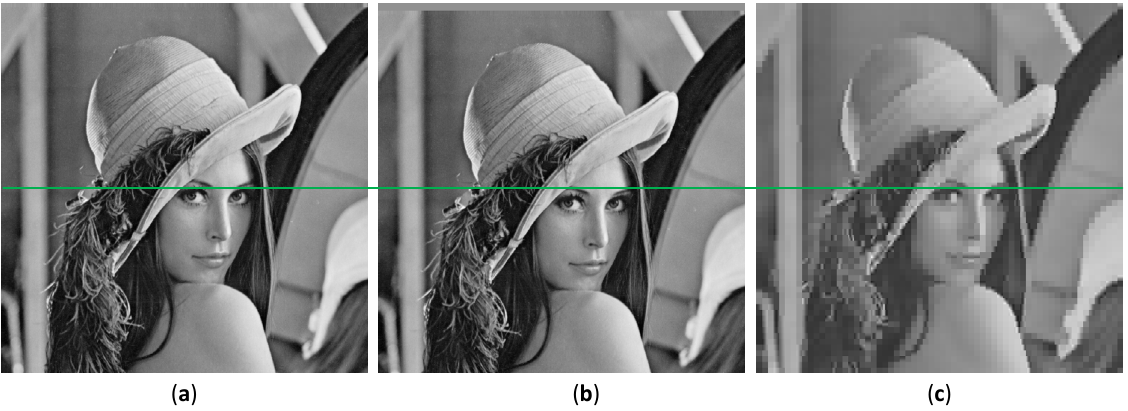
Figure 10. Demonstration using “Lena” to present the comparison among ( a ) original, ( b ) vertical translation, and ( c ) JPEG compressed images with a green line indicating the image’s vertical center (adapted from [17]).